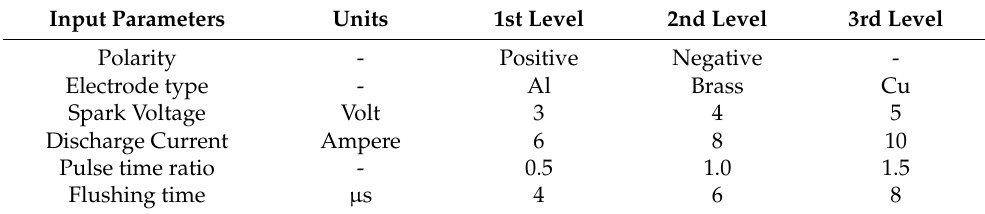
Table 3. Input parameters and their levels.